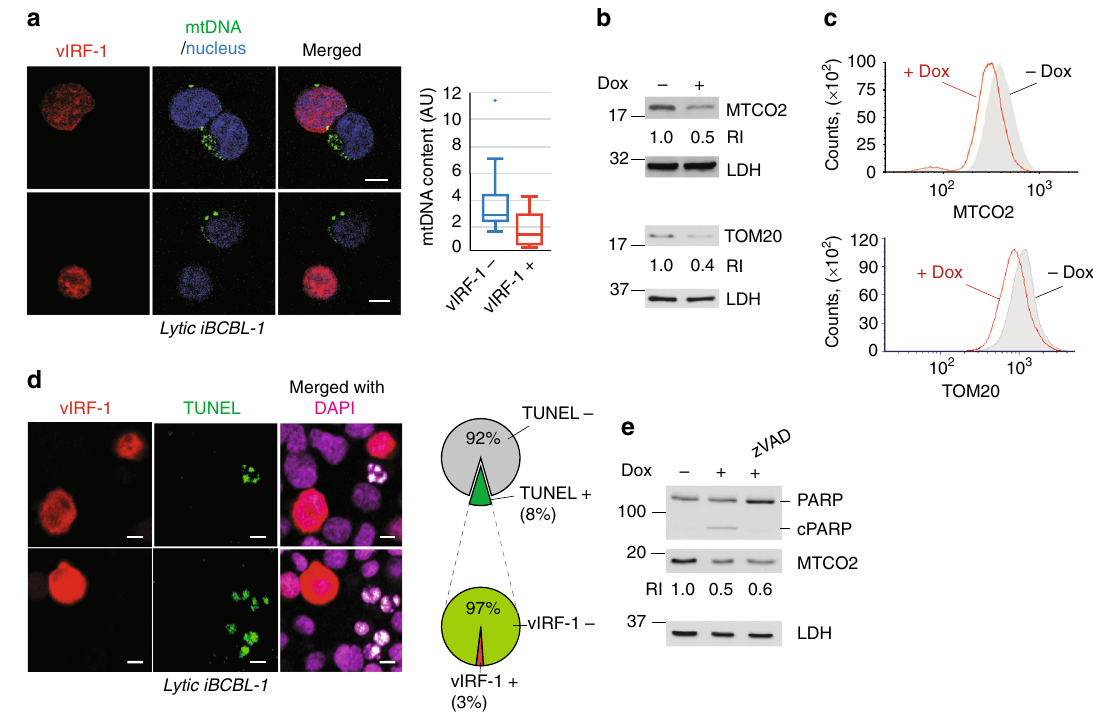
Fig. 1 Mitochondria content decreases during virus replication. a Quantitative assessment of mitochondrial DNA (mtDNA) in lytic (Dox + , 2 days) iBCBL-1 cells; a combined approach of IFA (for vIRF-1 protein) and FISH (for mtDNA) was used. Sixteen images were taken randomly, and representative images are presented. Scale bar, 5 µ m. The levels of mtDNA in individual cells were measured using ImageJ, and the distribution of data is shown in the boxplots that display the full range of variation (whiskers), the likely range of variation (box), the median (center line), and the outlier (dot). AU, arbitrary units. b , c Immunoblotting and image cytometric analyses of MTCO2 and TOM20. Lactate dehydrogenase (LDH) was used as loading control. RI, relative intensities of protein bands, normalized to LDH. d In situ detection of apoptosis by TUNEL in lytically reactivated iBCBL-1 cells (Dox + , 2 days). Following TUNEL reaction, the cells were immunostained with vIRF-1 antibody. Approximately 1200 cells were counted from six randomly selected images, and the percentages of TUNEL-positive cells and vIRF-1-negative and -positive cells among TUNEL-positive apoptotic cells are shown in pie charts. Scale bar, 5 µ m. e PARP cleavage analysis by immunoblotting of the extracts derived from latent and lytic (Dox + , 2 days) iBCBL-1 cells. Ten micromolar zVAD was added to the culture 24 h before cell harvest. Source data are provided as a Source Data fi